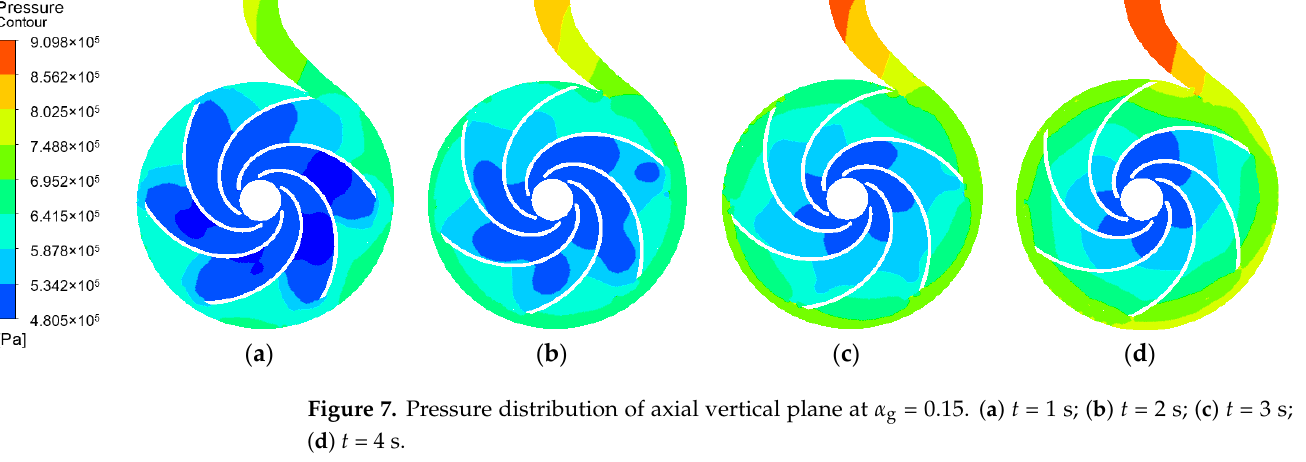
g = 0.15. ( a ) t = 1 s; ( b ) t = 2 s; ( c ) t = 3 s;